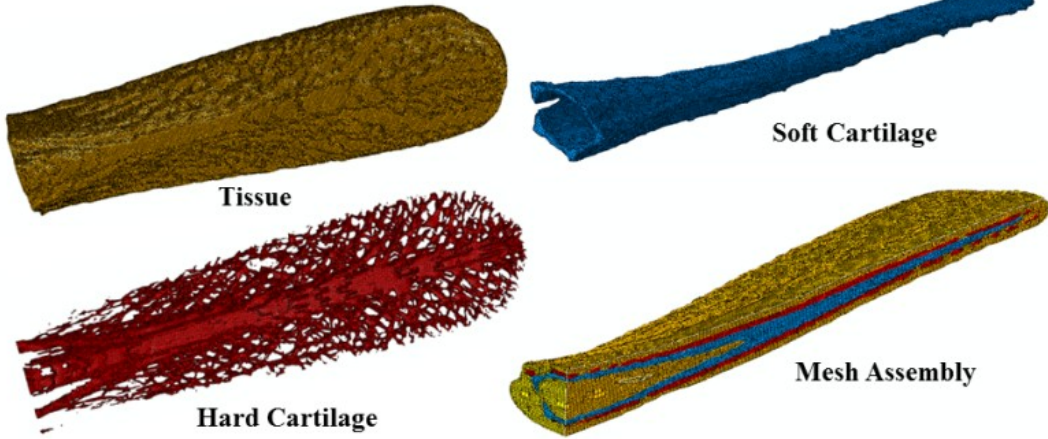
Figure 11. Abaqus mesh model of the rostrum. Dorsal view of tissue and hard cartilage on the left, lateral view of soft cartilage and oblique lateral sagittal section of mesh assembly on the right.